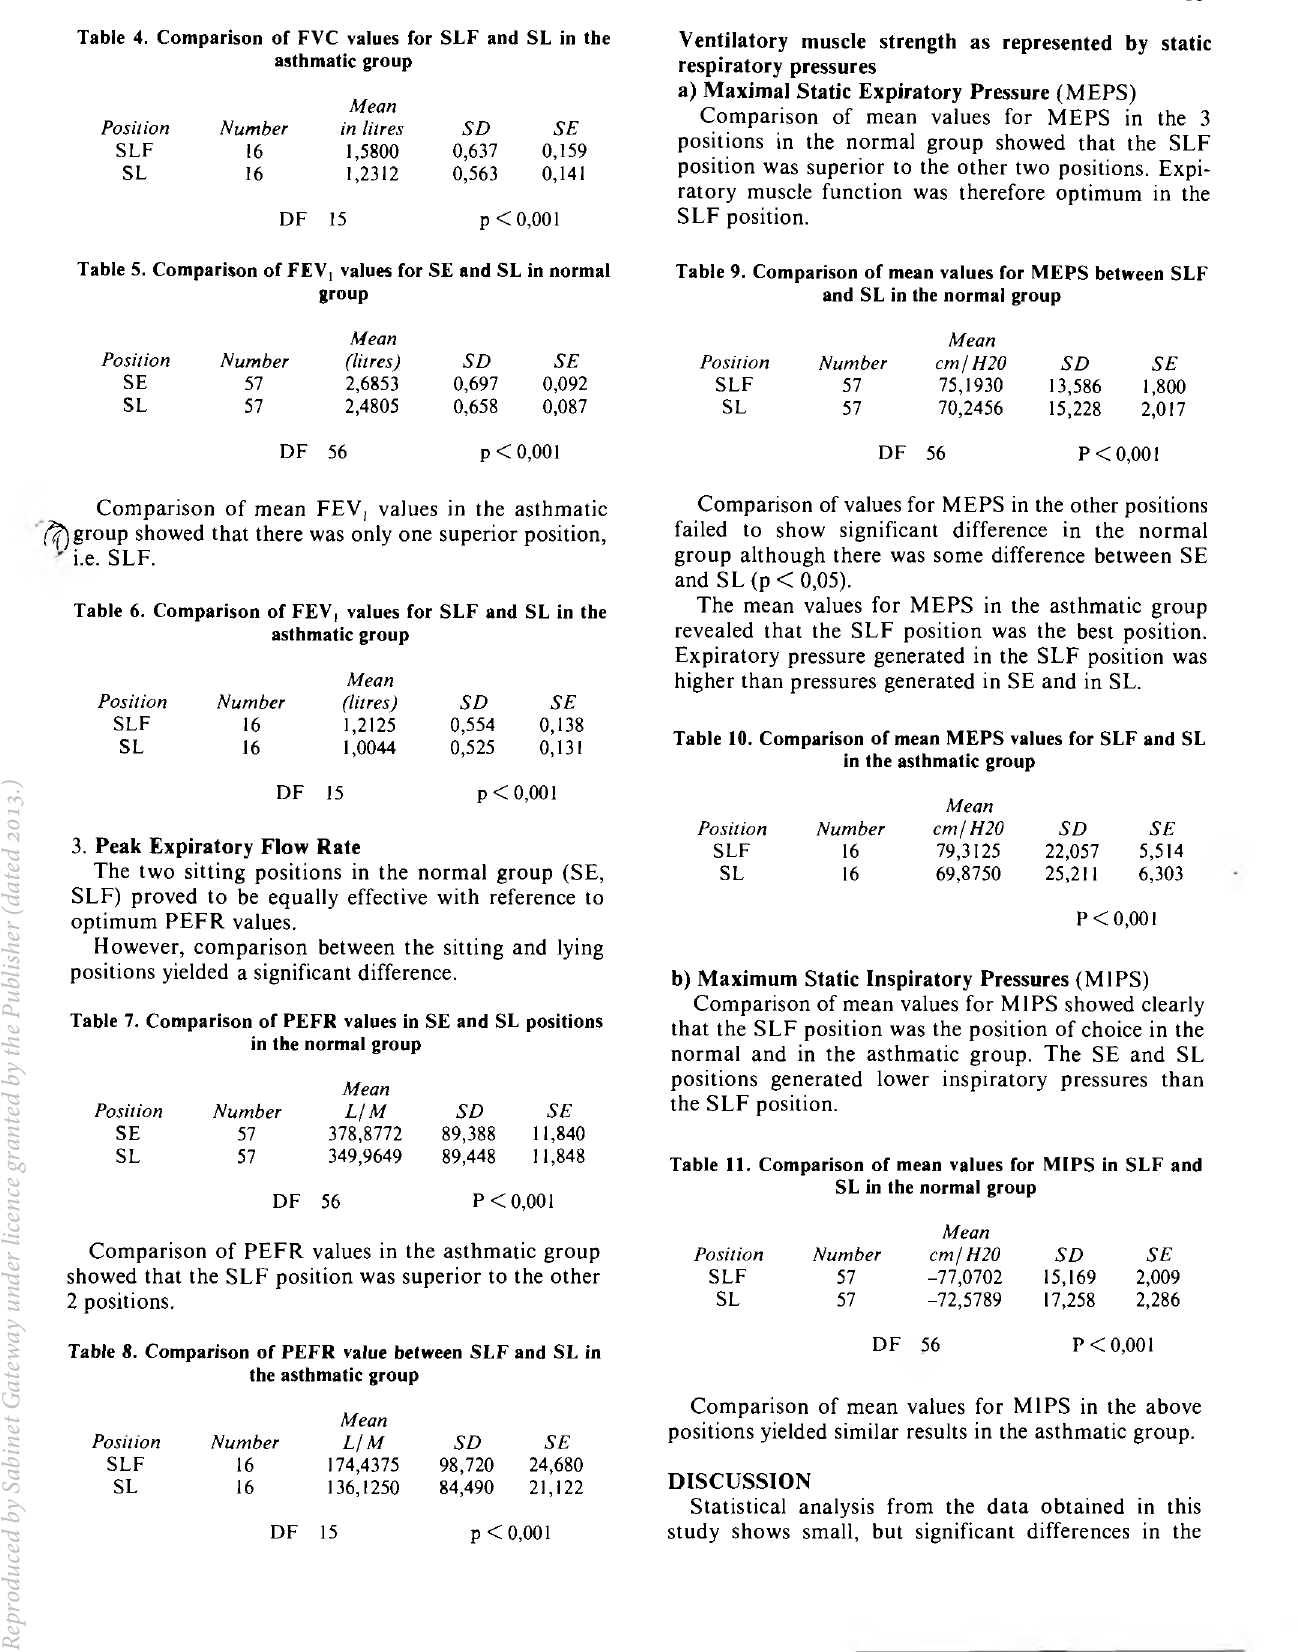
Table 4. Comparison of FVC values for SLF and SL in the asthmatic group Mean Position